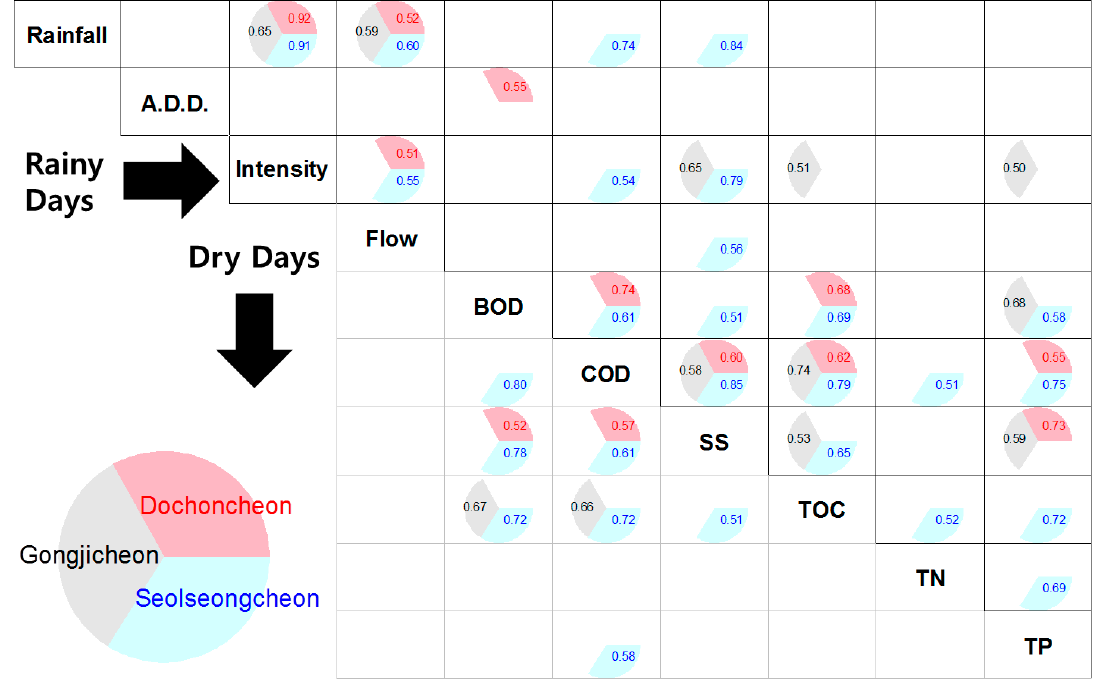
Figure 7. Correlation between the hydrological and the water quality characteristics during rainy (above) and dry (below) days (red text: Dochoncheon, grey text: Gongjicheon, blue text: Seolseongcheon).